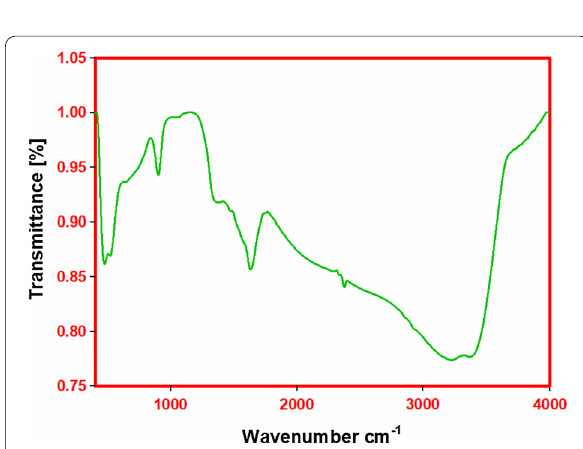
Fig. 2 FTIR spectrum of sodium titanate nanotubes (STNTs)